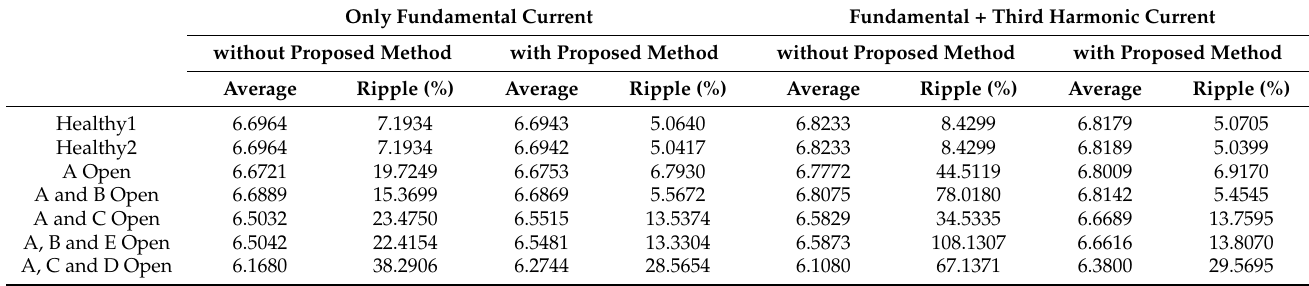
Figure 16. FEA torque waveforms for the fault-tolerant control currents of the NATPOC condition with and without proposed method: ( a ) Only fundamental; ( b ) fundamental plus third harmonic. Table 2. FEA average torque results and